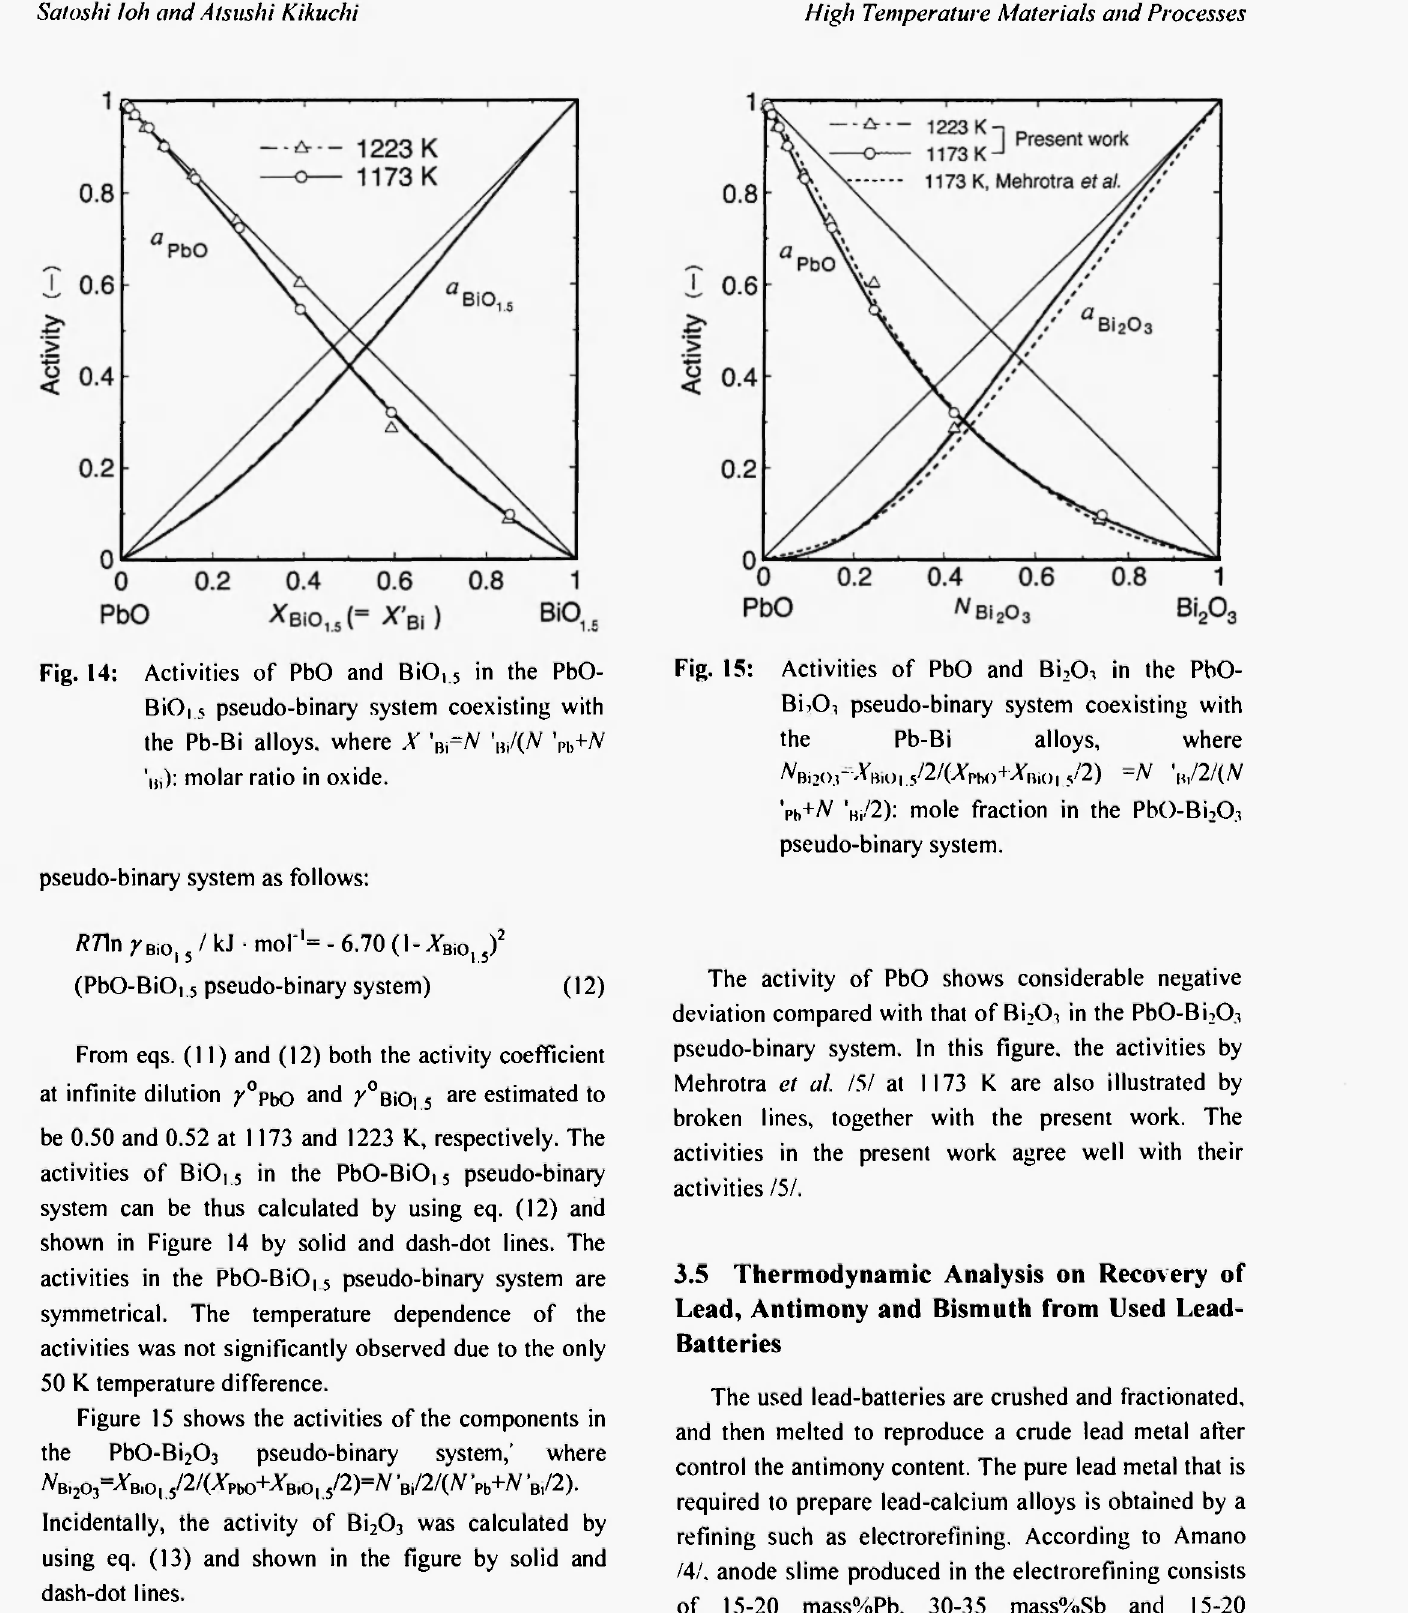
Fig. 14: Activities of PbO and BiO, 5 in the PbO- BiOi s pseudo-binary system coexisting with the Pb-Bi alloys, where X ' Bj =/V ' n J(N ' Pb +N Vi): molar ratio in oxide.